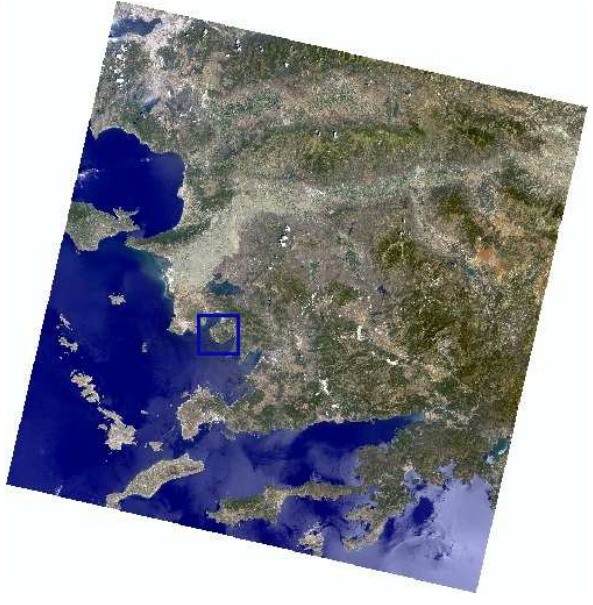
Figure 2. Landsat 8 OLI image full scene (RGB)